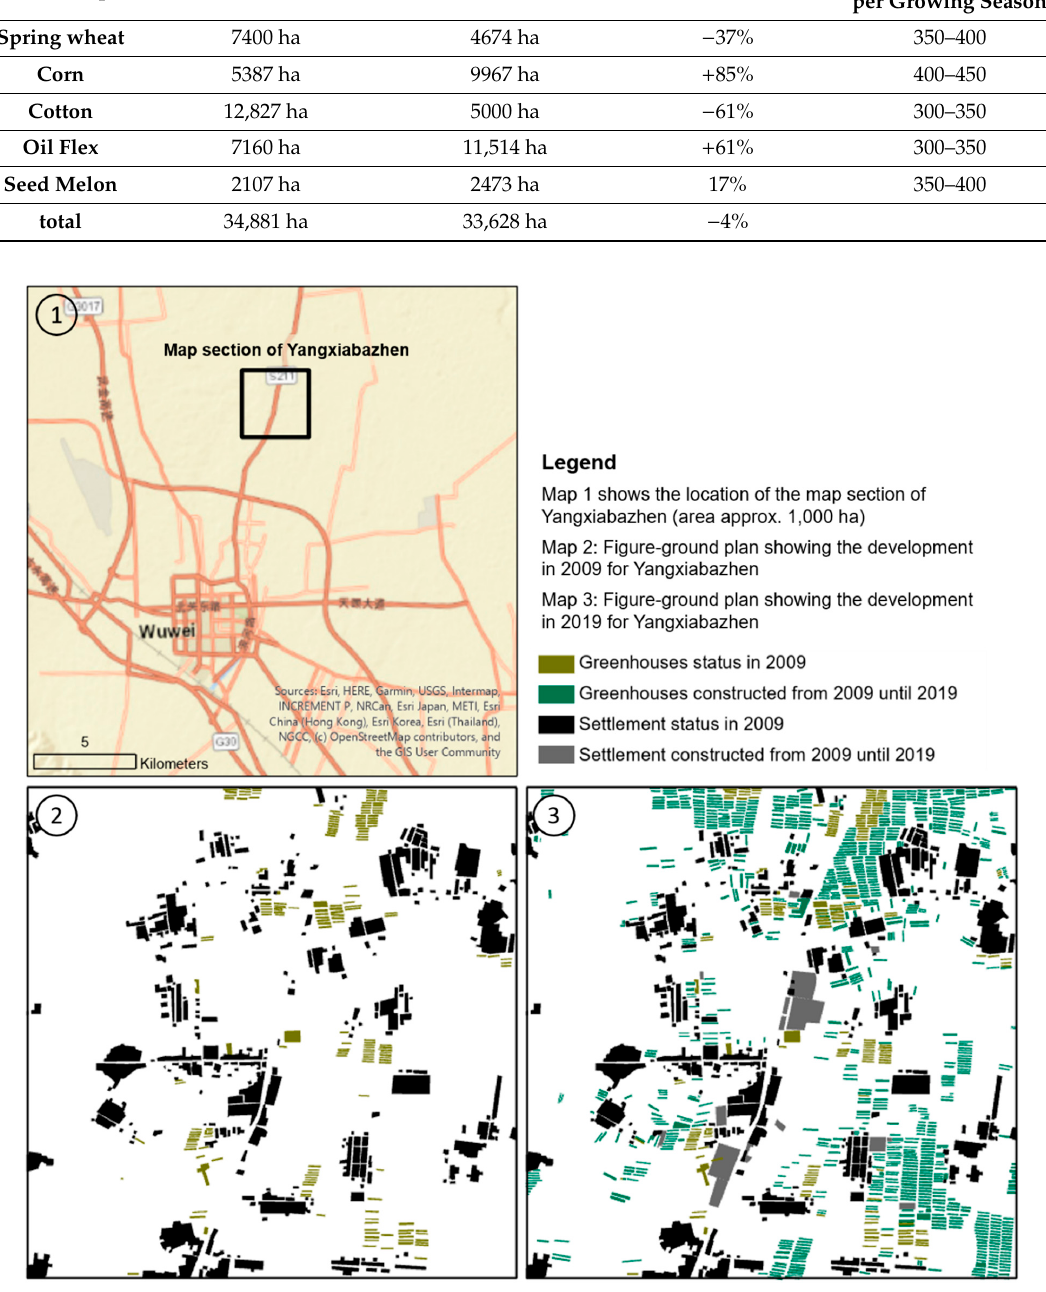
Figure 5. Figure-ground plans showing the development of greenhouses for a map section of Yangxiabazhen from 2009 to 2019 (own analysis). Yangxiabazhen from 2009 to 2019 (own